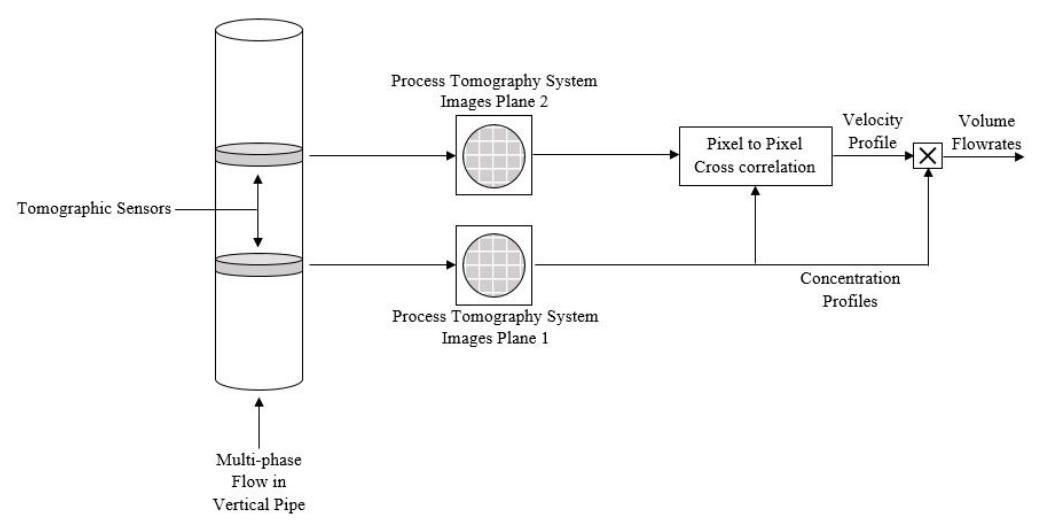
Figure 4. Multi-phase flow measurement using tomography imaging process.